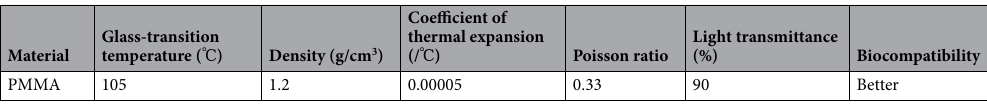
Table 2. The properties of PMMA